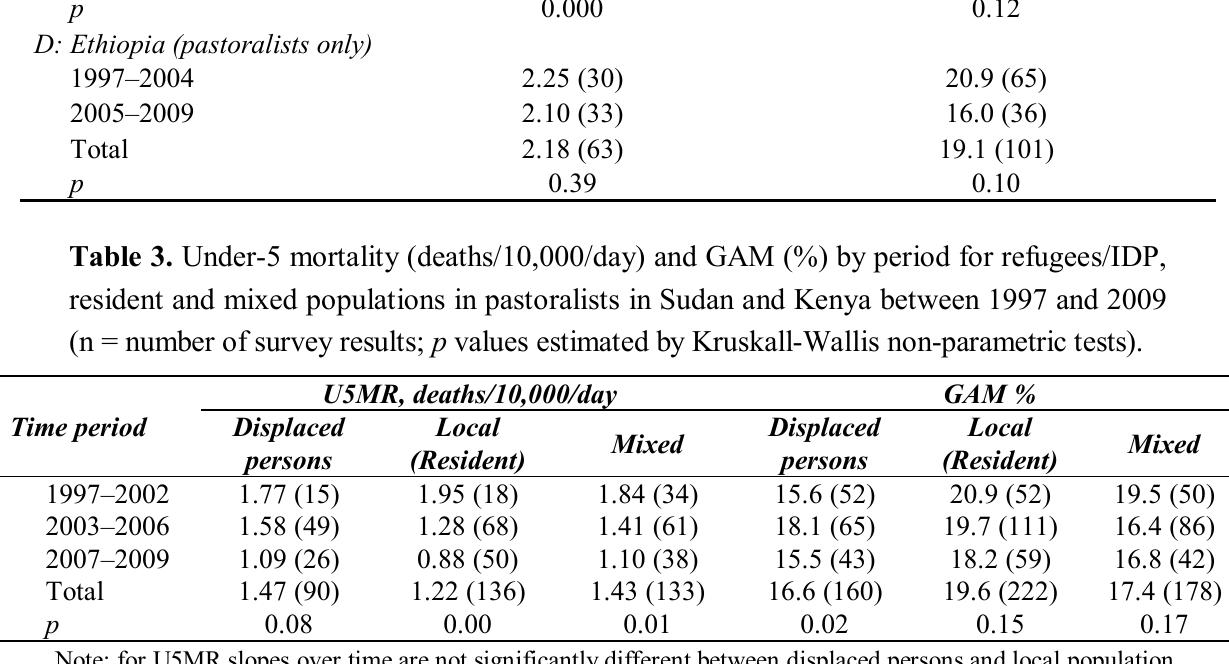
Global Acute Malnutrition (with oedema included) (n)